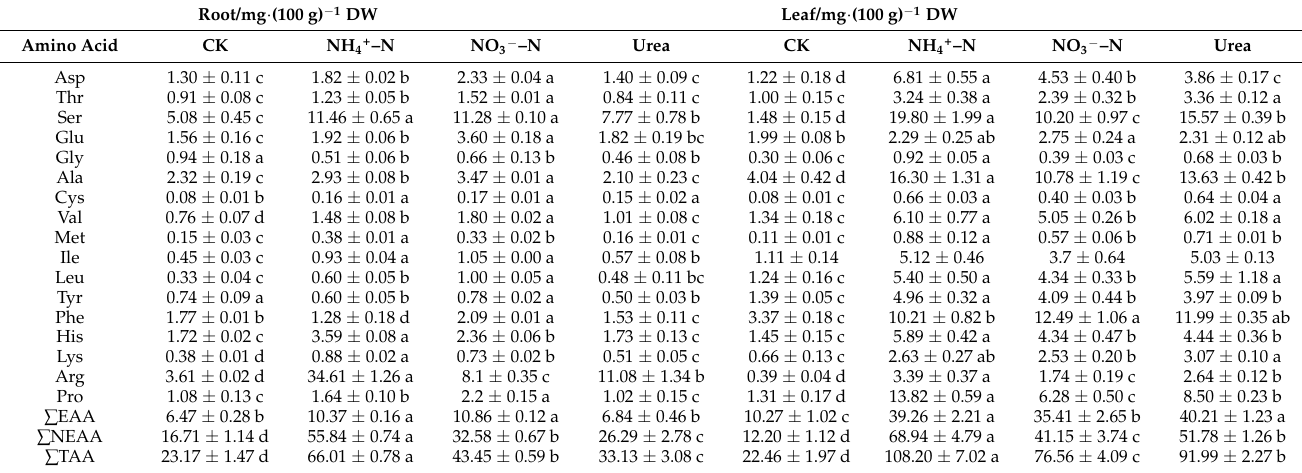
Table 3. Concentrations of free amino acids in blackberry roots and leaves with different N treatments.